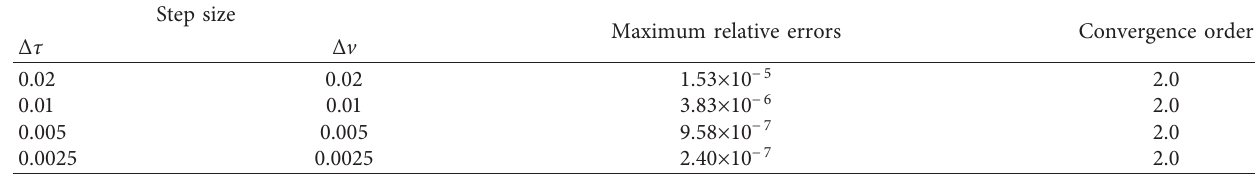
in the domain 0 ≤ τ ≤ 100 and 0 ≤ num .